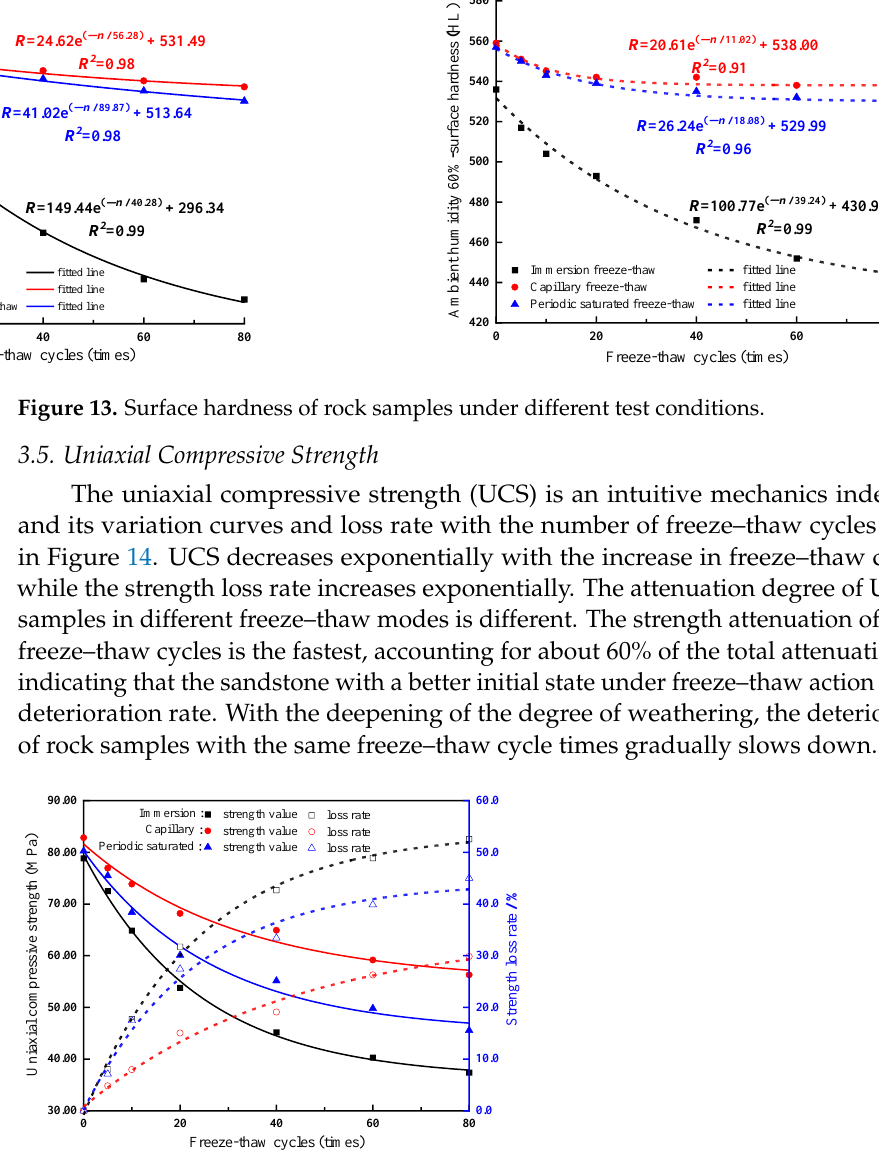
Figure 14. UCS and loss rate of rock under freeze–thaw action, the solid lines show the trend of strength value change, and the dotted lines reflect the variation characteristics of strength loss rate.